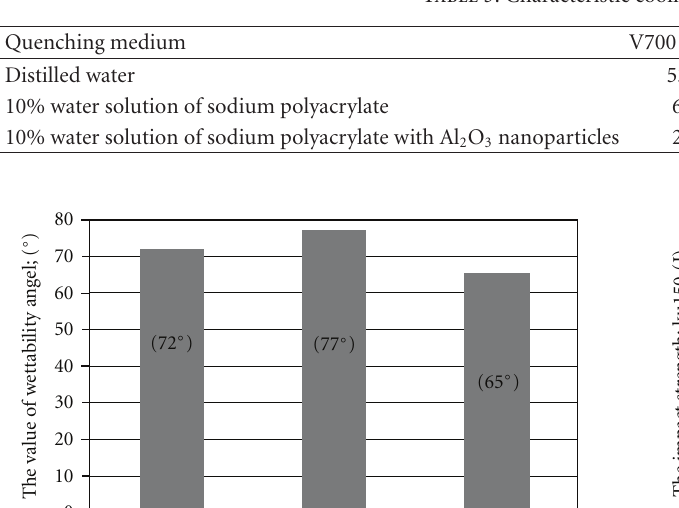
Figure 1: The cooling curve after mathematical analysis based on Fourier series for distilled water (1), 10% polymer water solution with (3) and without (2) 1% of Al 2 O 3 nanomolecules in co-ordinate systems: (a) Time-Temperature; (b) Cooling speed-Temperature. Table 3: Characteristic cooling speed values.